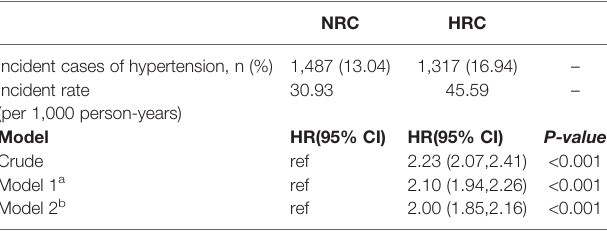
TABLE 4 | Baseline HRC was associated with subsequent hypertension in Cohort 1.